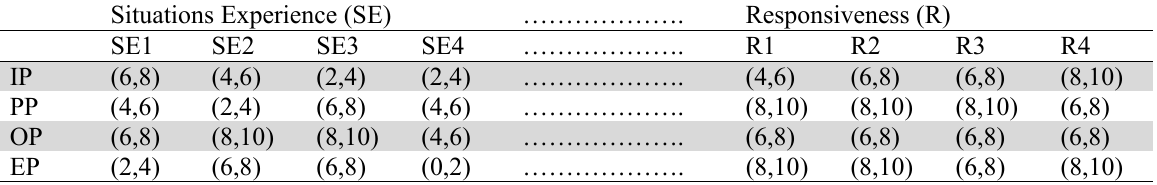
Stage 3: Convert Linguistic Evaluations into grey numbers. The linguistic criteria values obtained in Table 2 were assigned with grey numbers as shown in Table 1 column 3. The results for Manager 1 are given in Table 4. Table 4 Showing Converted Linguistic Decision matrix Evaluations into grey numbers. Situations Experience (SE)